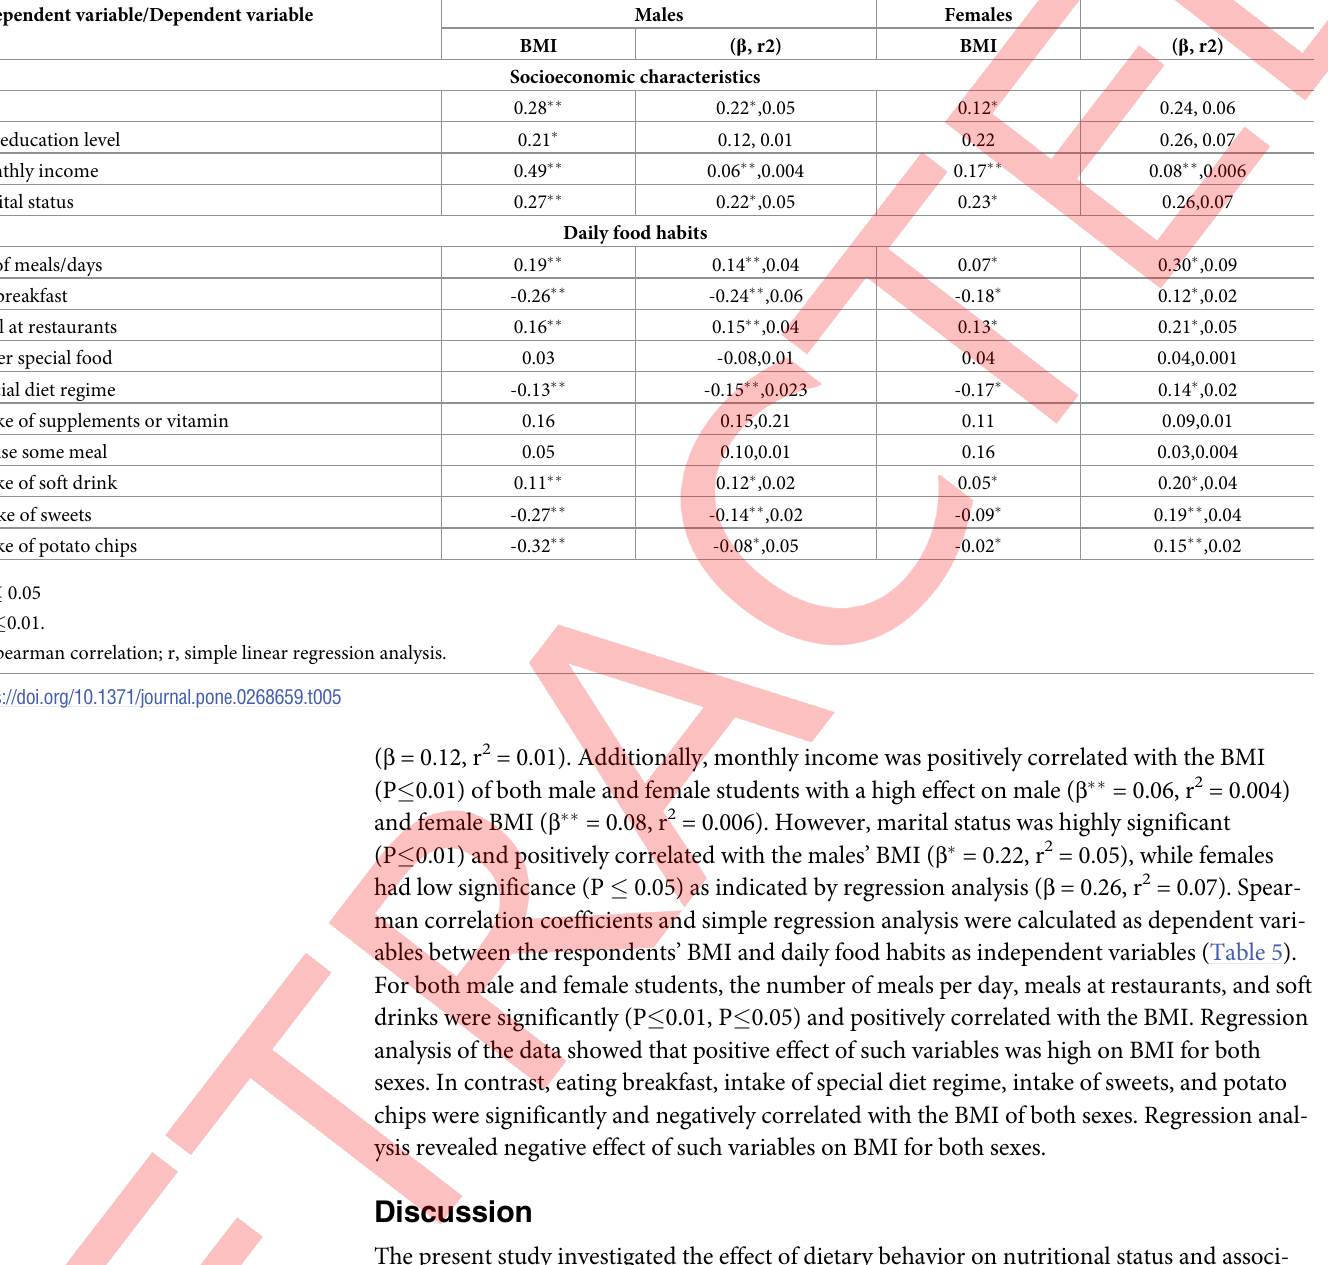
Table 5. Spearman correlation and simple linear regression analysis between socioeconomic characteristics, daily food habits, and the body mass index (BMI) of the Yemeni students male and